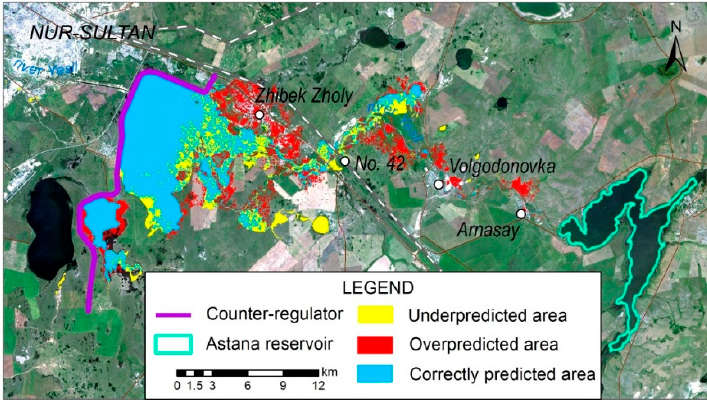
Figure6. InundationareasderivedfromsatelliteimageandsimulationbyHEC-RAS(yellow—underpredicted Figure 6. Inundation areas derived from satellite image and simulation by HEC-RAS area, red—overpredicted area, blue—correct prediction). (yellow—underpredicted area, red—overpredicted area, blue—correct prediction).